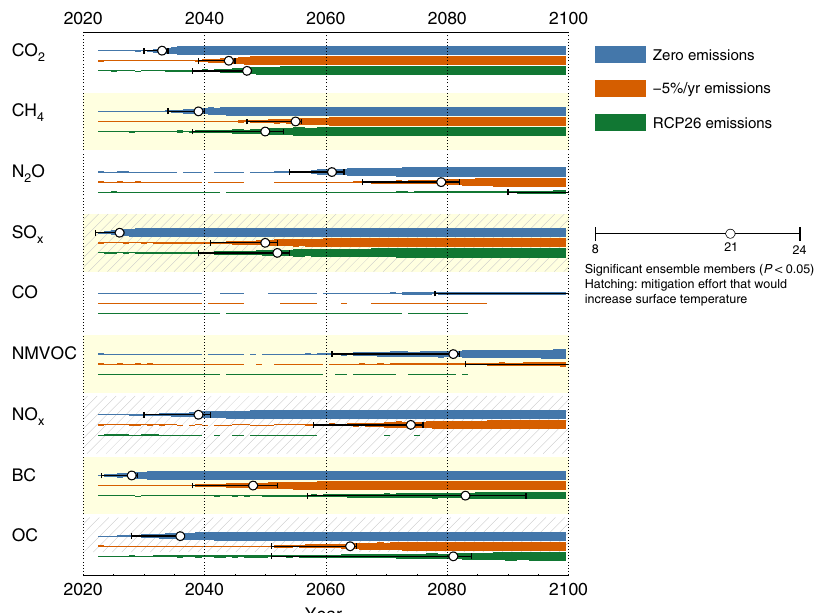
Fig. 3 Emergence times after single forcer mitigation. Time of emergence of a global mean surface temperature signal for idealized individual mitigation efforts of a range of short- and long lived climate forcers. The colored expanding bars show the evolution of a statistically signi fi cant signal ( t -test, p < 0.05), from zero (minimum) to 32 (maximum) ensemble members. The circles show the fi rst year when 66% (21 members) show signi fi cant signals. The error bars show the 25 – 75% range (8 and 24 signi fi cant members respectively). The underlying calculations are illustrated in Fig. 2. Hatching indicates a positive global temperature change in response to the mitigation (i.e. loss of